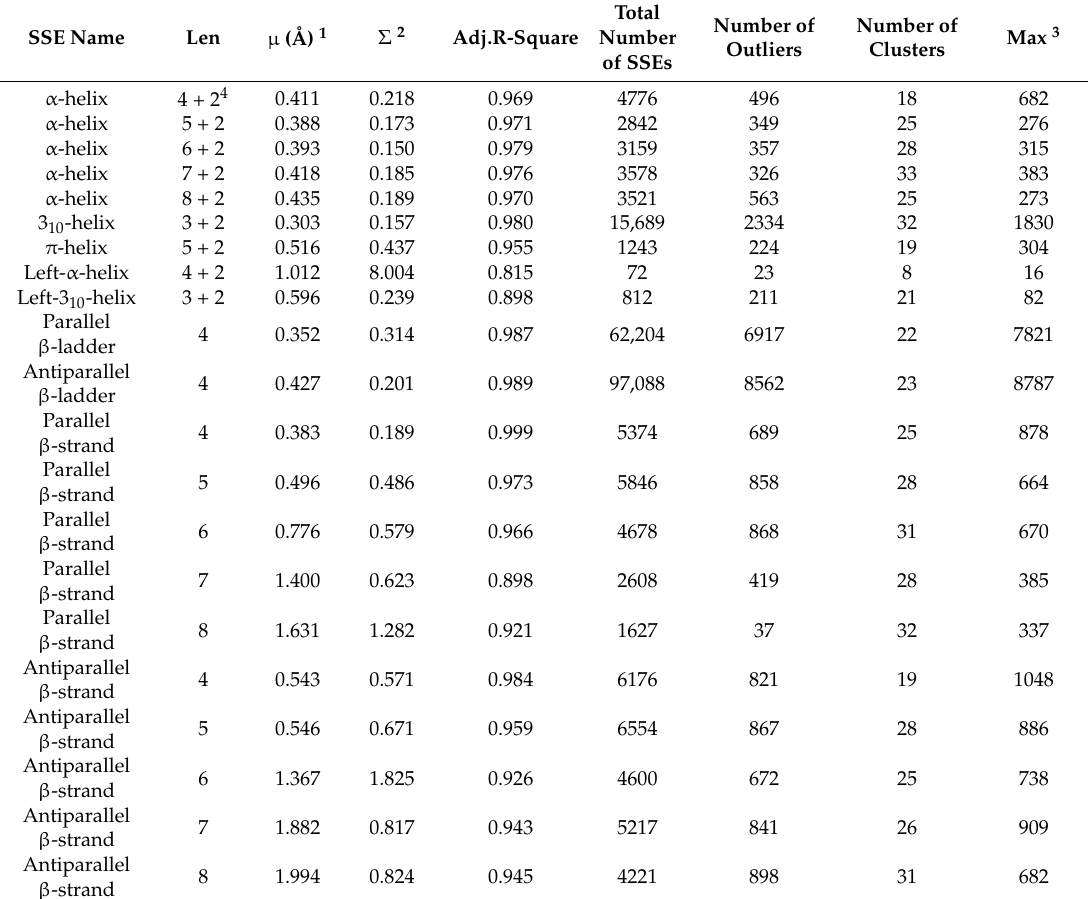
Table 6. The normal distribution parameters and clustering information for 21 secondary structure